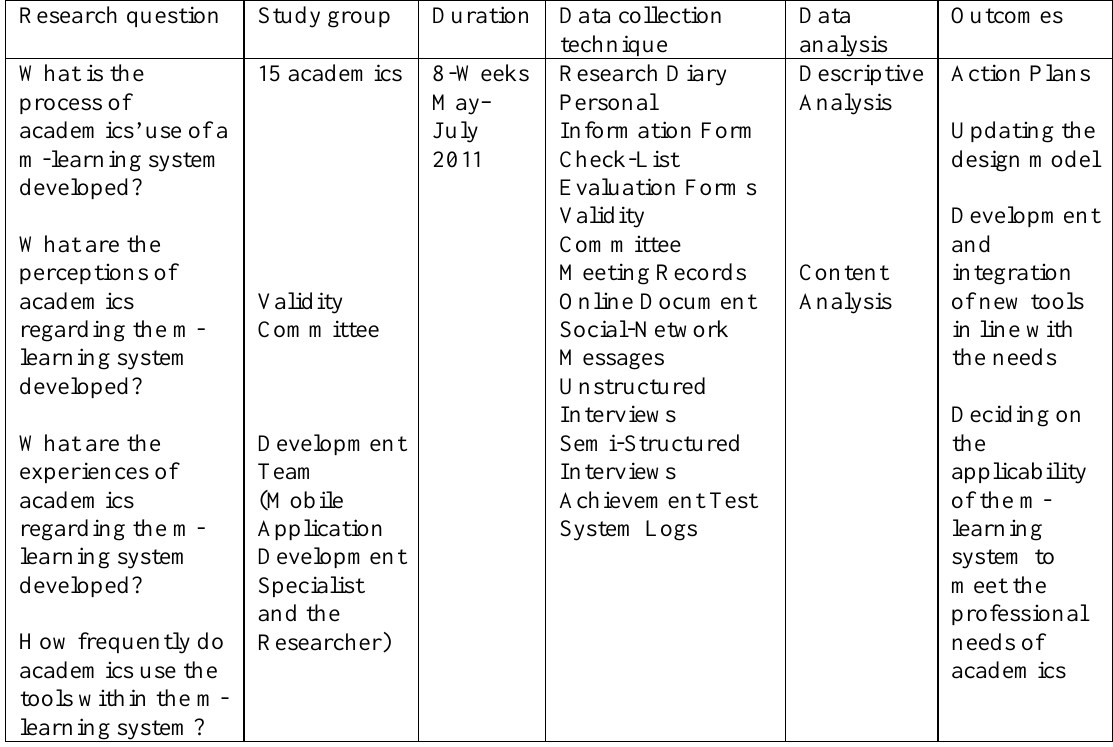
The Phase of Testing and Evaluation of the Solutions in